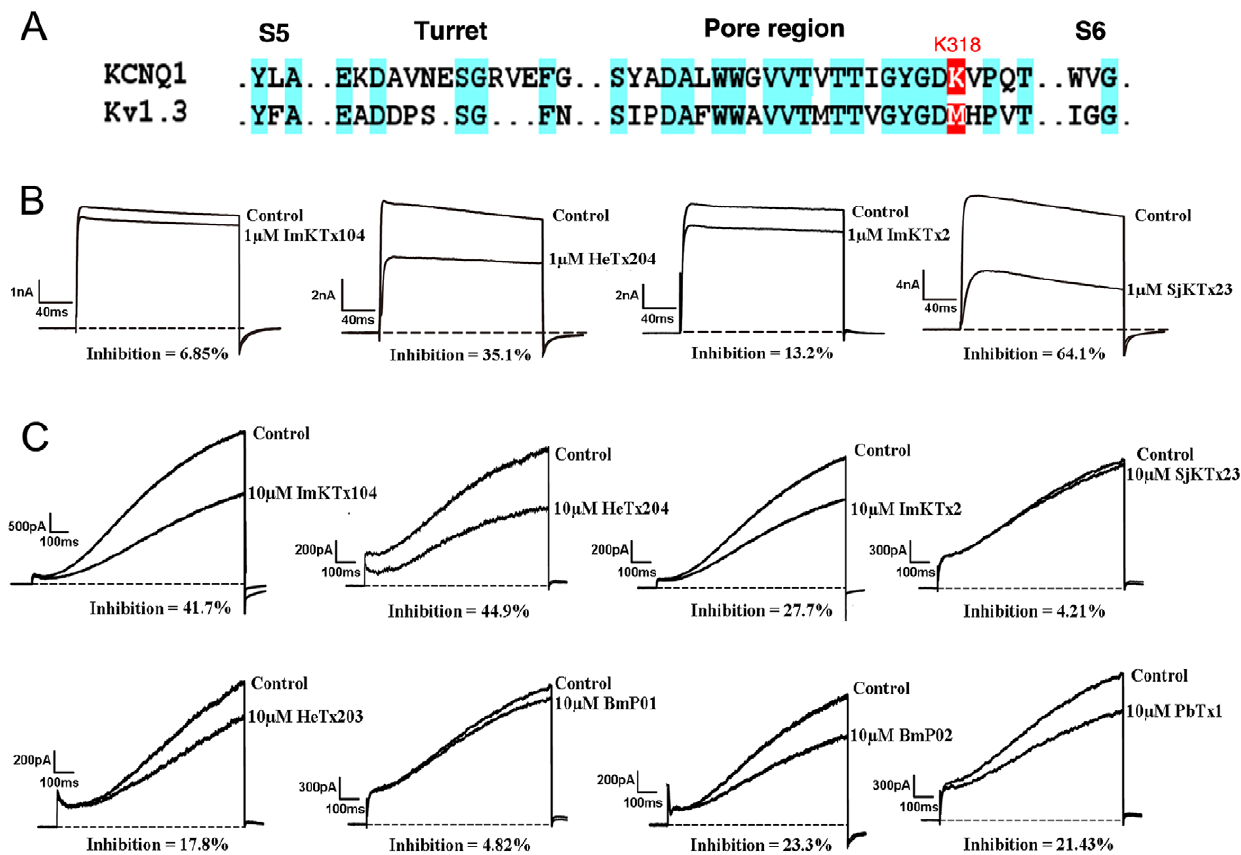
Figure 5. Functional evaluation of representative acidic KTxs. (A) Sequence alignment of Kv1.3 and KCNQ1 channels; (B) Inhibition of Kv1.3 channel current with 1 m M ImKTx104, HeTx204, LmKTx2, and StKTx23; (C) Inhibition of KCNQ1 channel current with representative acidic KTxs (10 m M). Average inhibition of different toxins is indicated (n . 3).